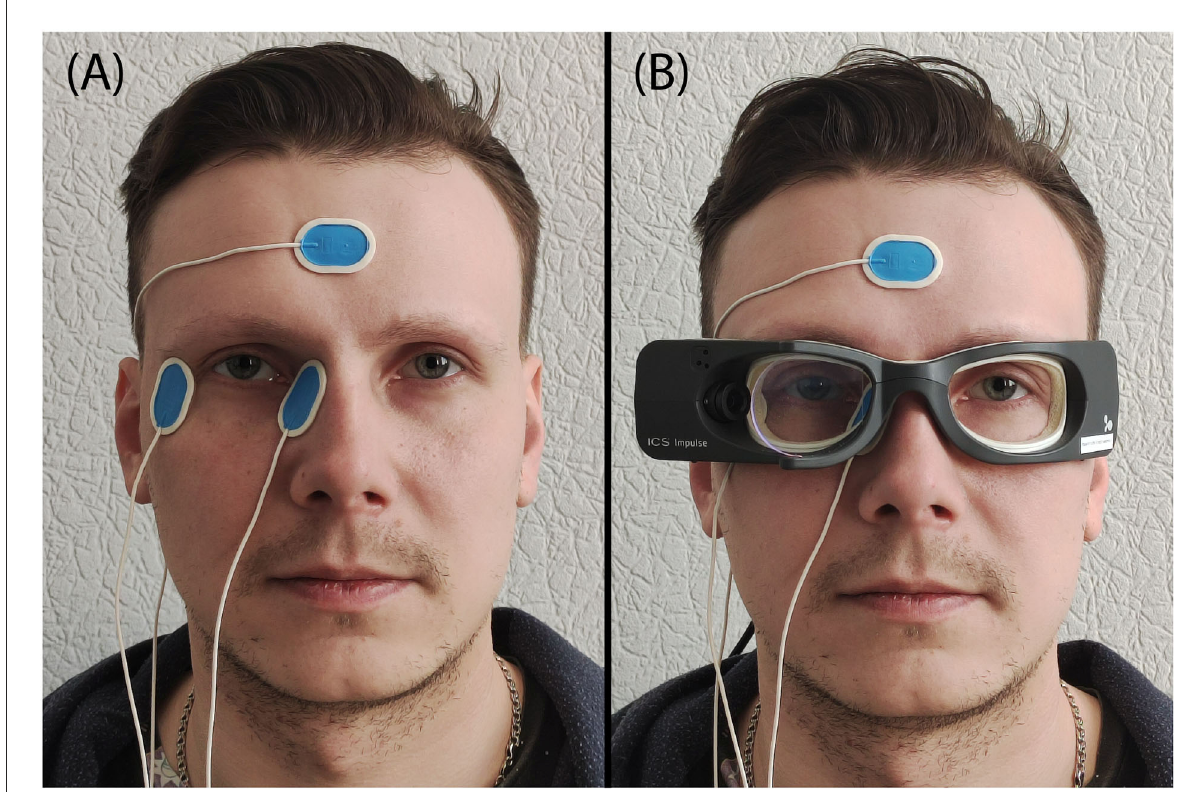
FIGURE1 Illustration of the placement of the electrodes and VOG goggles. (A) Location of the EOG electrodes, (B) ICS Impulse goggles together with the EOG